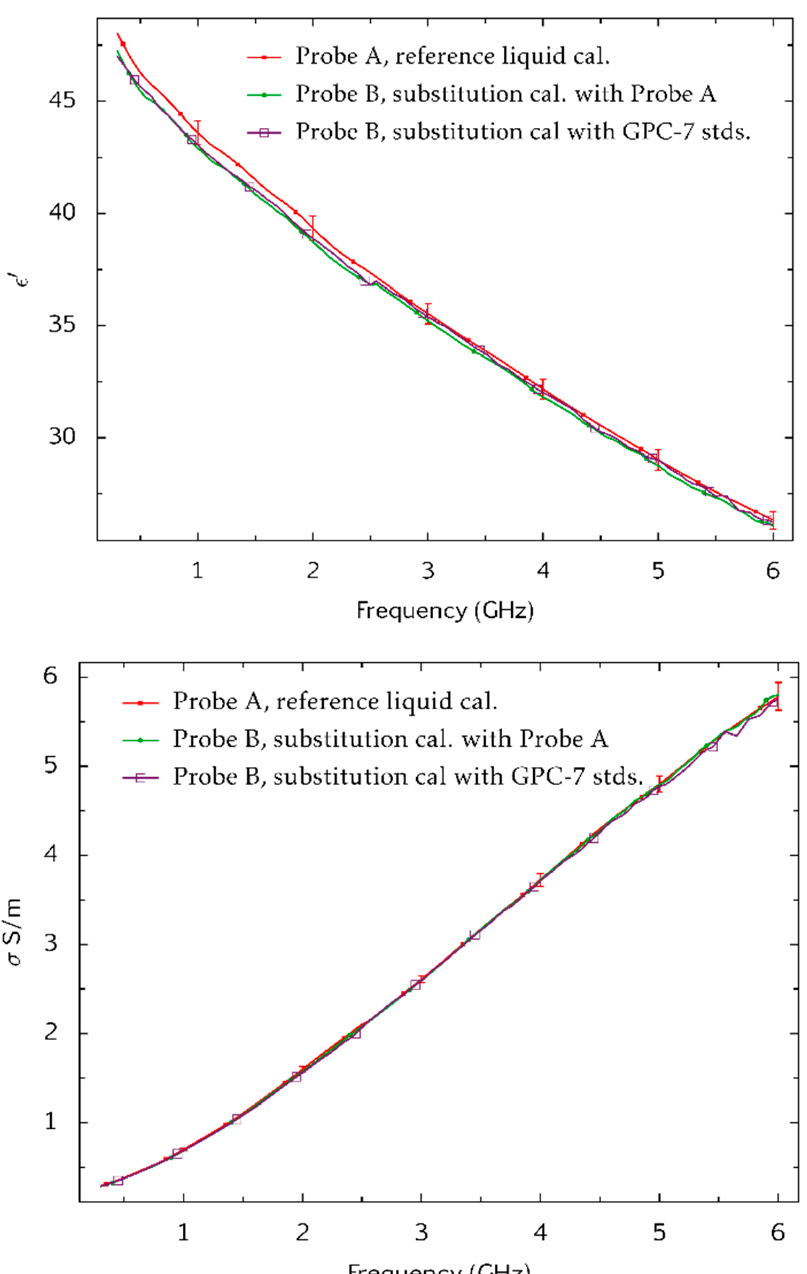
Figure 9. Measurements of the dielectric properties ε ’ ( top ) and σ ( bottom ) of a tween-based tissue equivalent liquid made with Probe A (reference liquid calibration) and Probe B (substitution calibration methods). These measurements were made at NPL by using a Rohde and Schwarz model ZVB20 VNA. Combined Type A and Type B uncertainties are shown for a coverage factor of k = 2 (equivalent to 95% confidence level). These were evaluated by Monte-Carlo modelling [20].